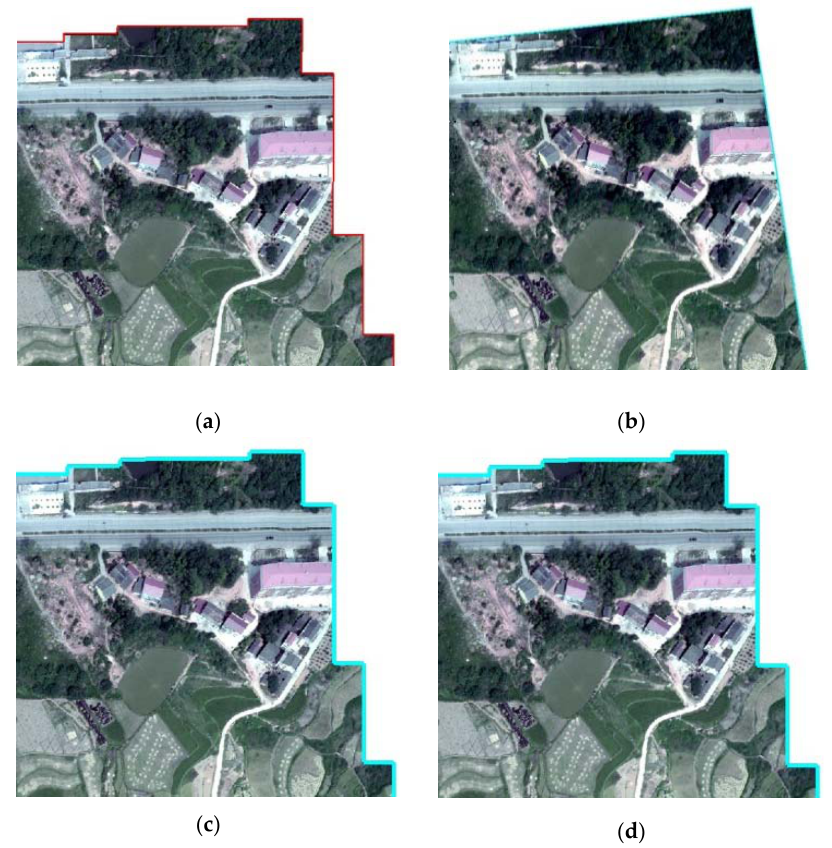
Figure 11. Details of ( a ) the yellow rectangular area marked in Figure 5; ( b ) the yellow rectangular area marked in Figure 10a; ( c ) the yellow rectangular area marked in Figure 10b; ( d ) the yellow rectangular area marked in Figure 6.